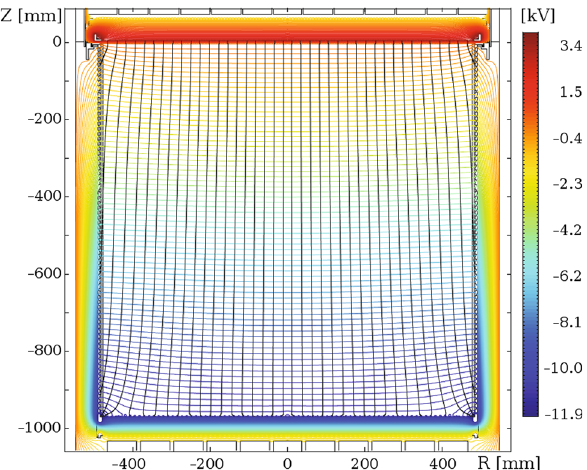
Fig. 3 Finite element simulation of the electric field configuration inside and outside of the TPC, separated by the gate and cathode as well as the field-shaping electrodes. The figure shows the field lines as well as the equipotential lines for cathode, gate and anode biased with − 12kV, 0kV and + 4kV, respectively, as realized during science run 0